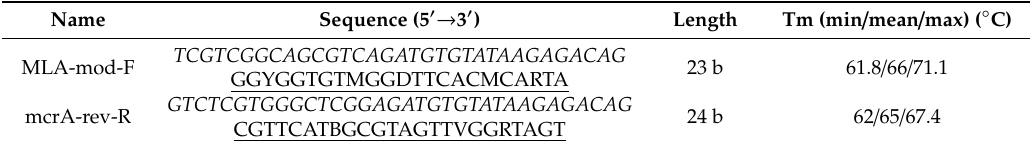
Table 1. Sequences of MLf / MLr primers (ML) [15] and MLA-mod-F / mcrA-rev-R primers (MLA) [14] used for amplification of mcrA gene (underlined) with Illumina overhang adapter sequences